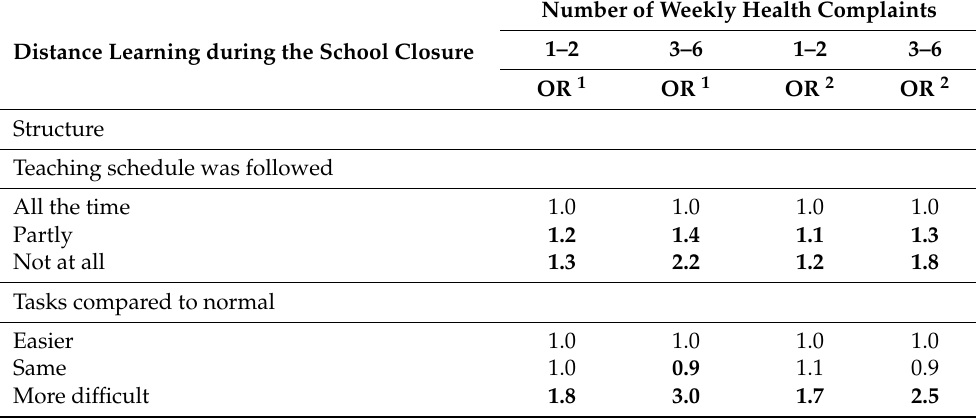
Table 3. Effects of distance learning variables on weekly health complaints. Results of multinomial logistic regression modelling. Odds ratios (ORs) of bivariate and multivariate models. Significant variables in